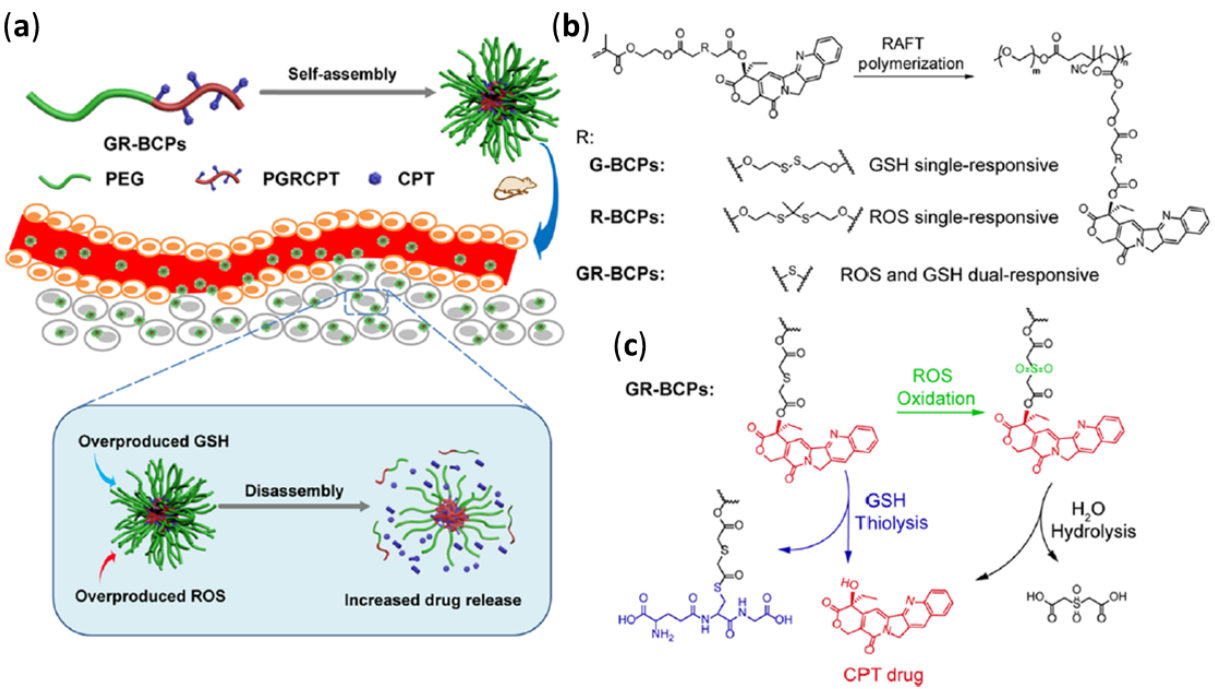
Figure 22. ( a ) Self-assembly of GSH- and ROH-dual-responsive BCPs (GR-BCPs) comprised of a PEG block and CPT-PMA conjugate block (PGRCPT; top). Disassembly of GR-BCP with subsequent CPT drug release in mouse tumor tissue (bottom). ( b ) Reversible addition-fragmentation chain transfer (RAFT) copolymerization of PGRCPT and PEG blocks, and structures of R groups for dual-responsive BCPs (GR-BCPs), and single-responsive BCPs that respond to GSH (G-BCP) or ROS (R-BCP). ( c ) GR-BCP structure before and after subsequent disassembly and CPT release for GSH- and RSH-triggered pathways. Reprinted with permission from [19]. Copyright (2020) American Chemical